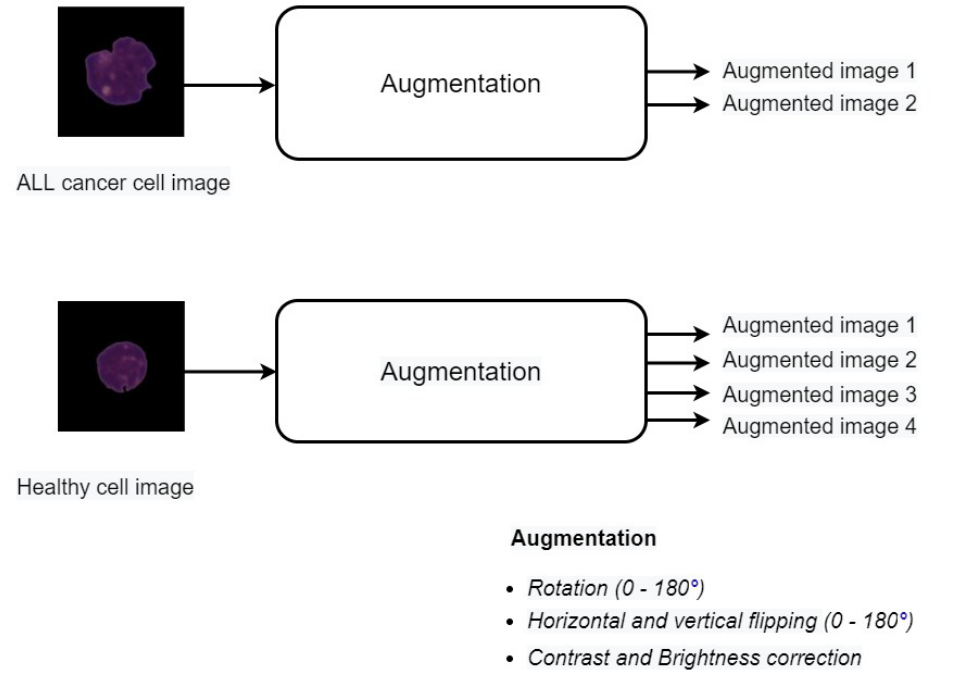
Figure 2. The illustration of the image augmentation process. Random rotation is applied to rotate the images clockwise, according to the value between ( − 45 to 45) degrees. Horizontal and vertical flipping was also applied on images to horizontally and vertically flip the entire rows and columns of an image to produce a mirror image. Table 2 represents our dataset distribution before and after augmentation for each fold, while Figure 3 represents the images before and after augmentation. There is a smaller number of healthy cell images than ALL cancer cell images in the C-NMC dataset. Therefore, to balance the dataset class-wise, we randomly applied the mentioned augmentation techniques on every image. These augmentation techniques always vary between flipping, rotation, contrast, and brightness correction. The healthy images are augmented at a double rate than ALL cancer cells to produce an equal number of images of both classes. Whenever the model gets an image, it generates two augmented images in the case of cancer cell images and four augmented images in the case of normal cell images.